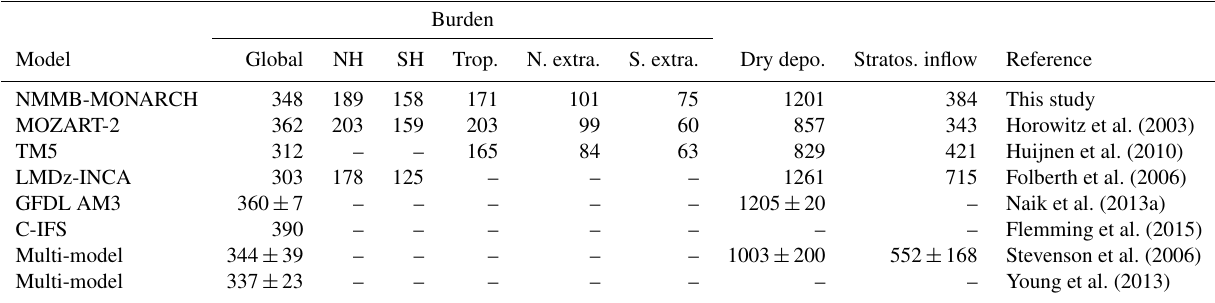
Table 7. Annual mean burden, dry deposition of tropospheric O 3 and stratospheric inflow (TgO 3 ) for the NMMB-MONARCH, MOZART-2, TM5, LMDz-INCA, GFDL AM3, and C-IFS global models, and two different multi-model ensembles (including 25 and 15 global models